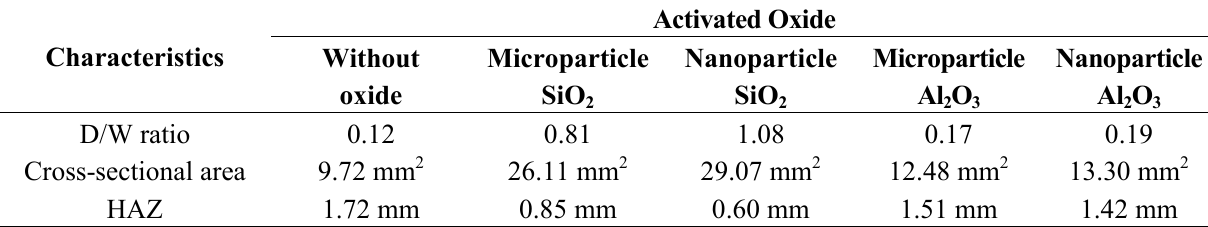
Table 5. Depth-to-width (D/W) ratio, cross-sectional area and heat-affected zone (HAZ) of TIG welds made with and without